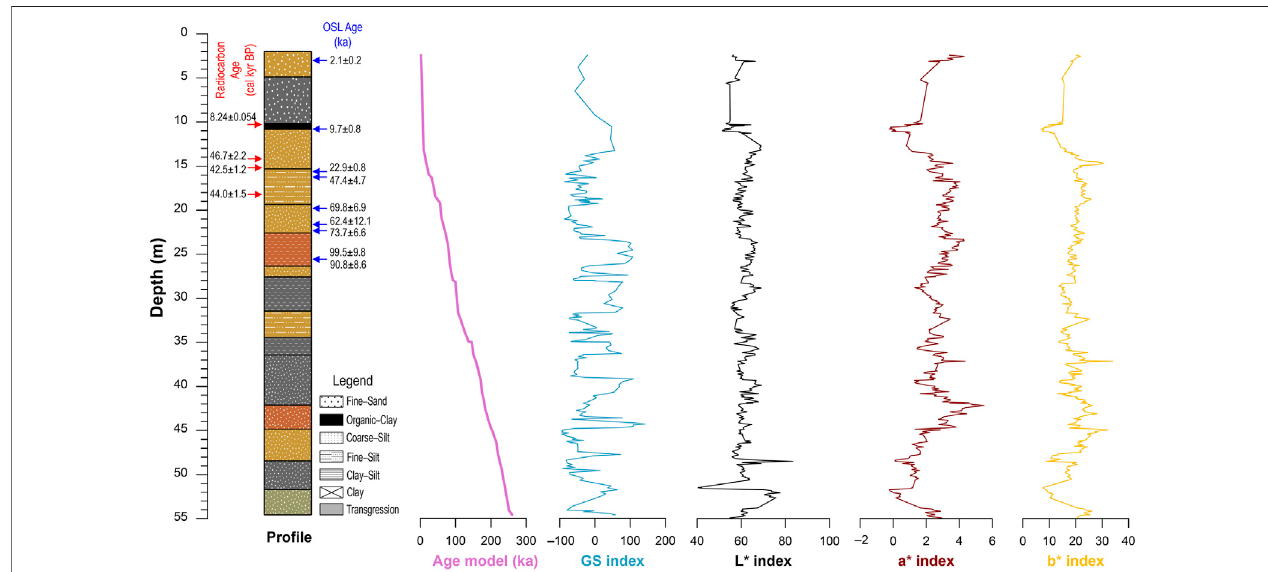
FIGURE 2 | Pro fi le with dating results and age model of core Lz908 (Yi et al., 2012a), changes in sediment grain size (GS index), and color indices (L*a*b*) in the CIELAB color space. L*, lightness; a*, redness (+)/greenness ( − ); b*, yellowness (+)/blueness ( − ).